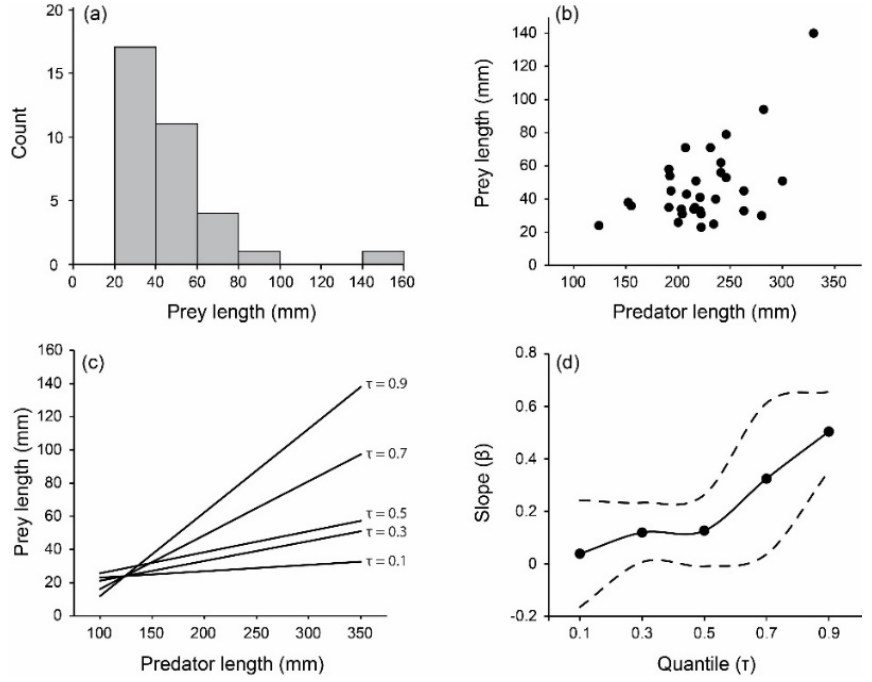
Figure 5. ( a ) Length frequency distribution of fish prey found in the stomachs of Brown Trout ( Salmo trutta ) across all six tributaries of the Jemez River watershed, New Mexico, from July to October 2020. ( b ) Prey lengths in relation to the lengths of Brown Trout that ate them. Each point represents a unique predator–prey interaction. ( c ) Line of best fit describing predator–prey length relationships across 0.1–0.9 quantiles ( τ ). For this study, we considered 0.1 and 0.9 τ to be the lower and upper bounds, respectively. ( d ) Slope coefficients ( β , black dots) and 95% confidence intervals (dashed lines) for each quantile regression